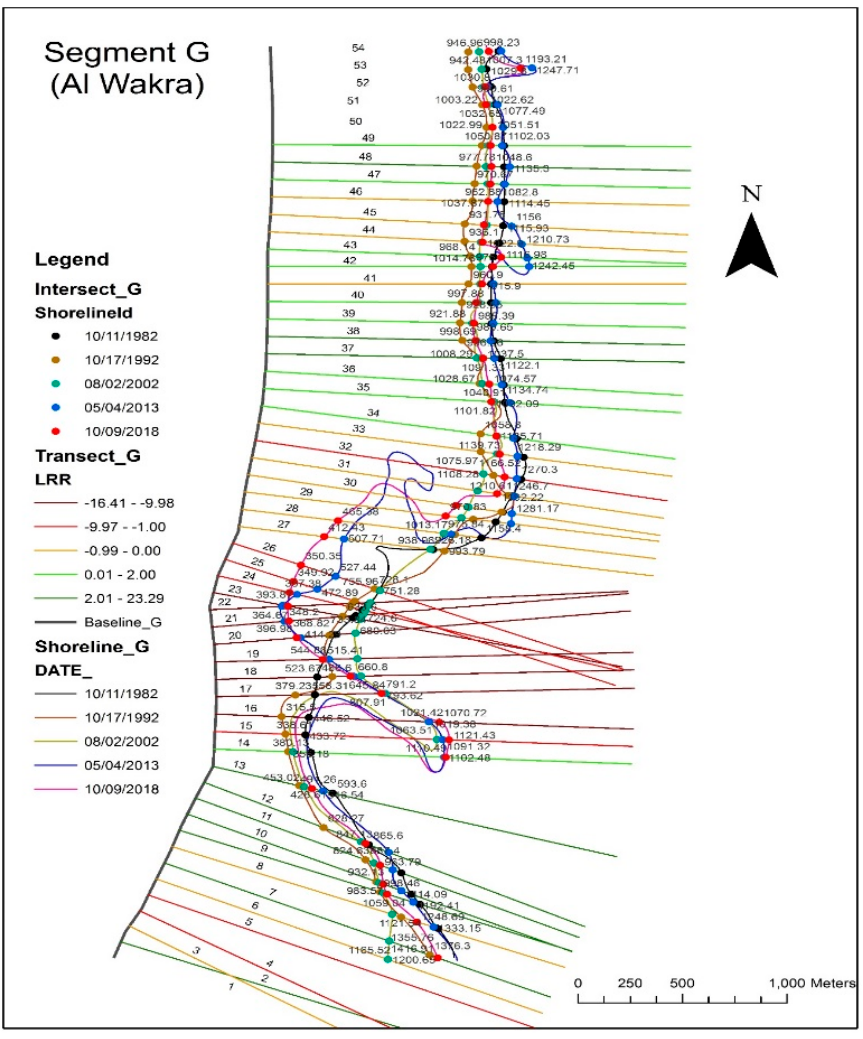
Figure 21. Al Wakra shoreline.